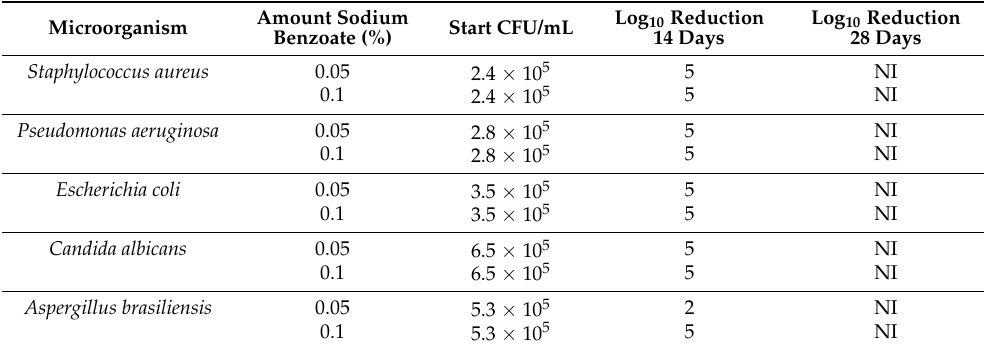
Table 9. Microbiological challenge test for Naloxone 1 mg/mL with preservative sodium benzoate. Results expressed as log10 reduction after 14 and 28 days.